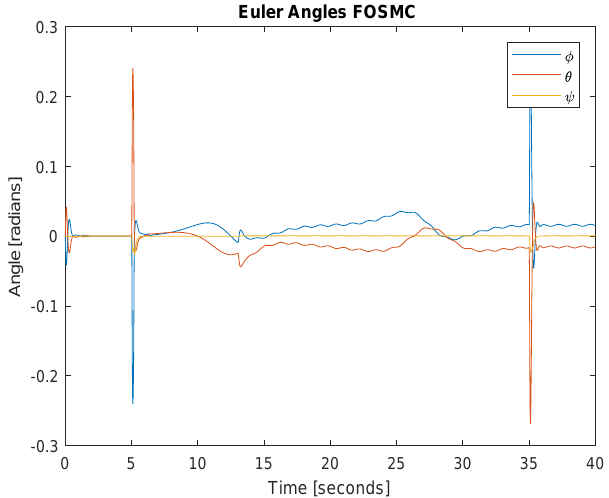
Figure 11. Euler Angles are within the small angle approximation.